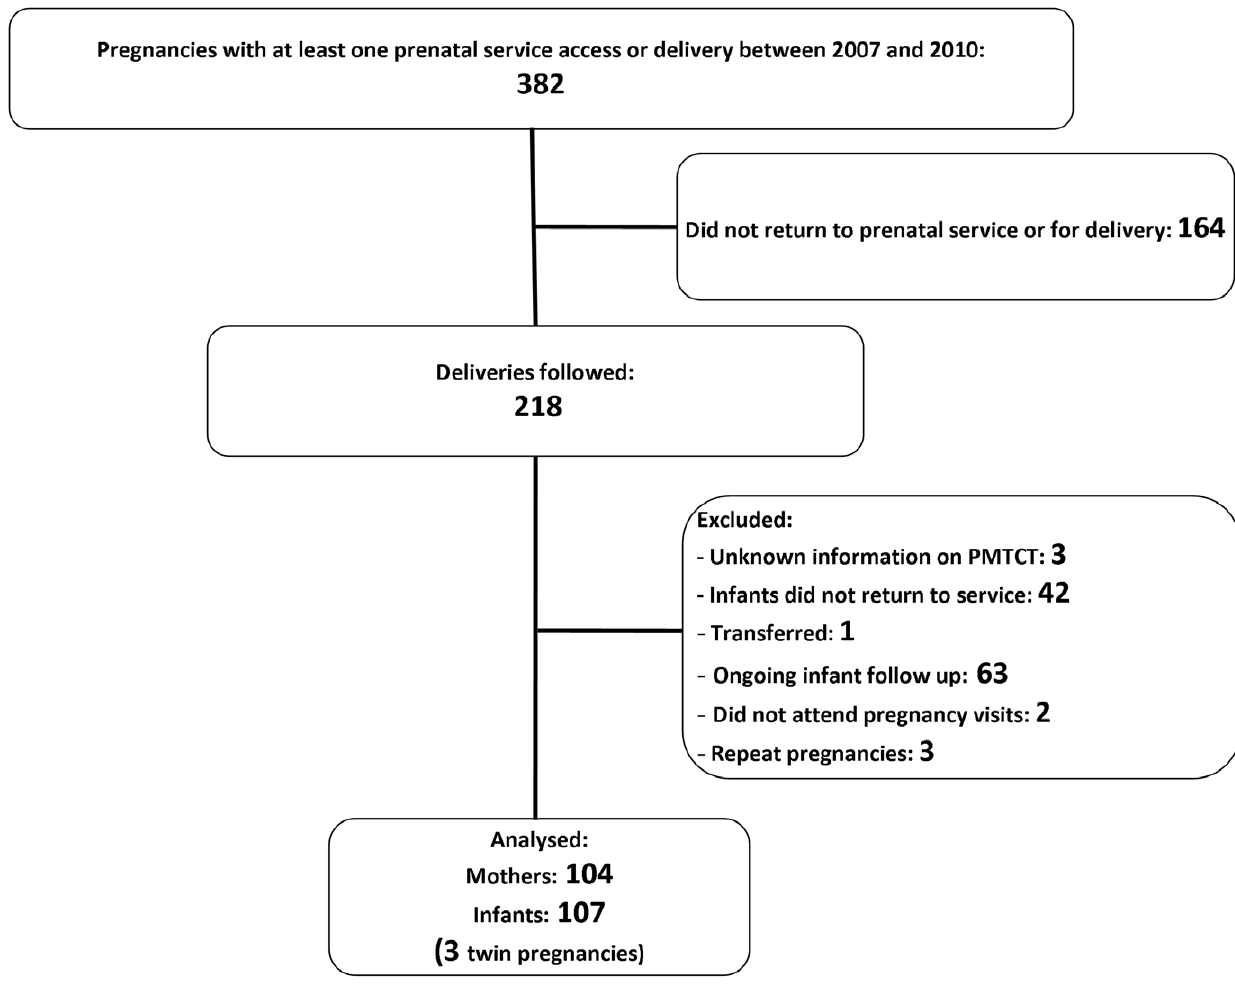
Figure 1. Population flowchart.